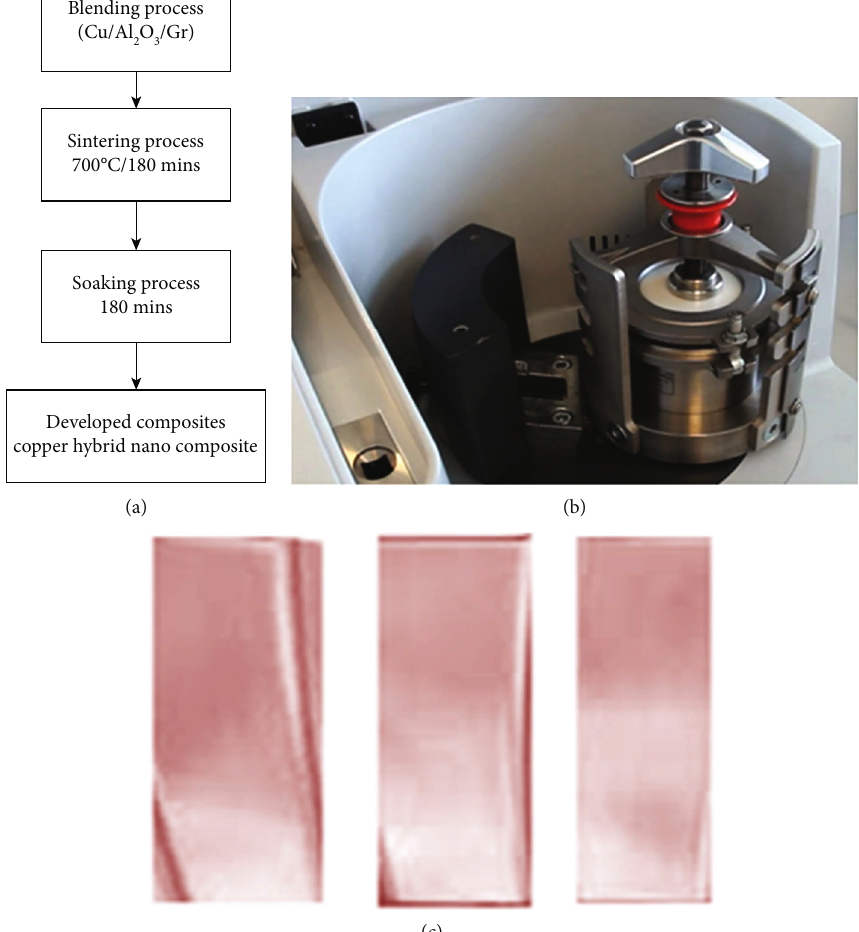
Figure 2: Overall powder metallurgy process: (a) process layout, (b) PM100 model planetary ball milling apparatus, and (c) developed composite samples.